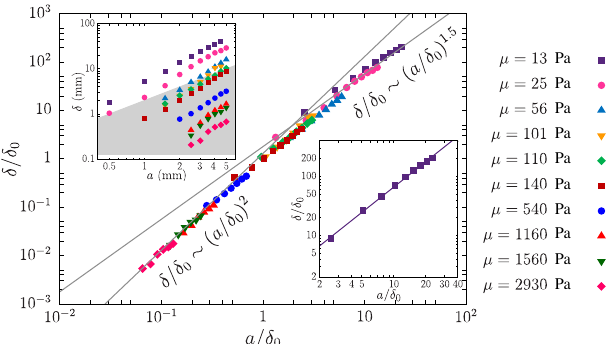
FIG. 3. Dimensionless depth of spheres ( δ = δ 0 ) plotted as a function of its dimensionless radius a= δ 0 , for various shear moduli of the gels from μ ¼ 13 Pa to 2930 Pa. The grey lines indicate power-law curves [ δ = δ 0 ∼ ð a= δ 0 Þ α ] with α ¼ 2 and α ¼ 1 . 5 for the two asymptotic limits for the normalized data. (Upper inset) Depths ( δ ) versus radii ( a ) for all the spheres. The plot area is divided into two domains, the boundary indicating δ ¼ 2 a . The data points above the boundary indicate that the spheres were entirely below the gel ’ s surface. (Lower inset) Best fit [ δ = δ 0 ¼ k ð a= δ 0 Þ α ] for the softest gel (13 Pa) highlighted (see